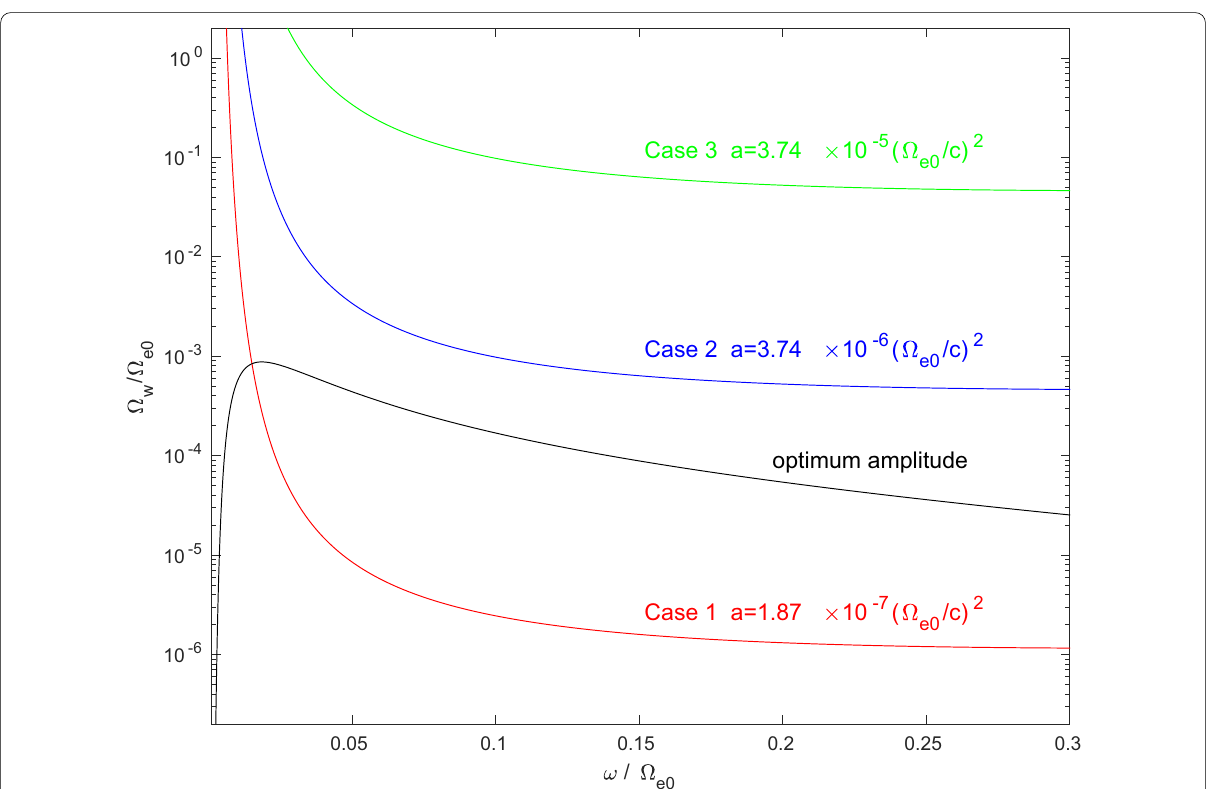
Fig. 2 Theoretical optimum and threshold amplitudes under different gradients of the background magnetic field with parameters | Q | = 0.1 , τ = 0.5 , ω pe = 15 � e 0 , ω ph = 0.3 � e 0 , U t � = 0.26 c and U t ⊥ = 0.3